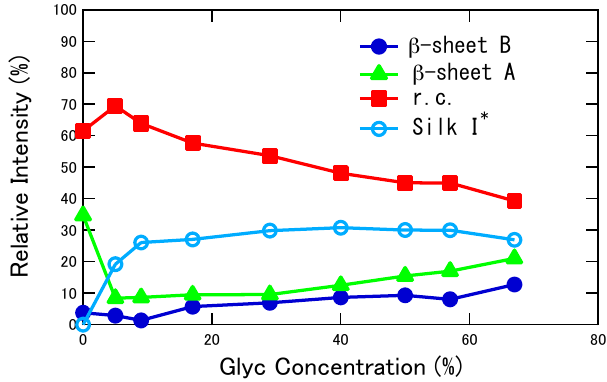
Figure 3. Change in the fraction of different conformations of SF and Glyc-blended SF films determined from the deconvolution of Ala C β peaks as a function of Glyc concentration. r.c.: random coil.